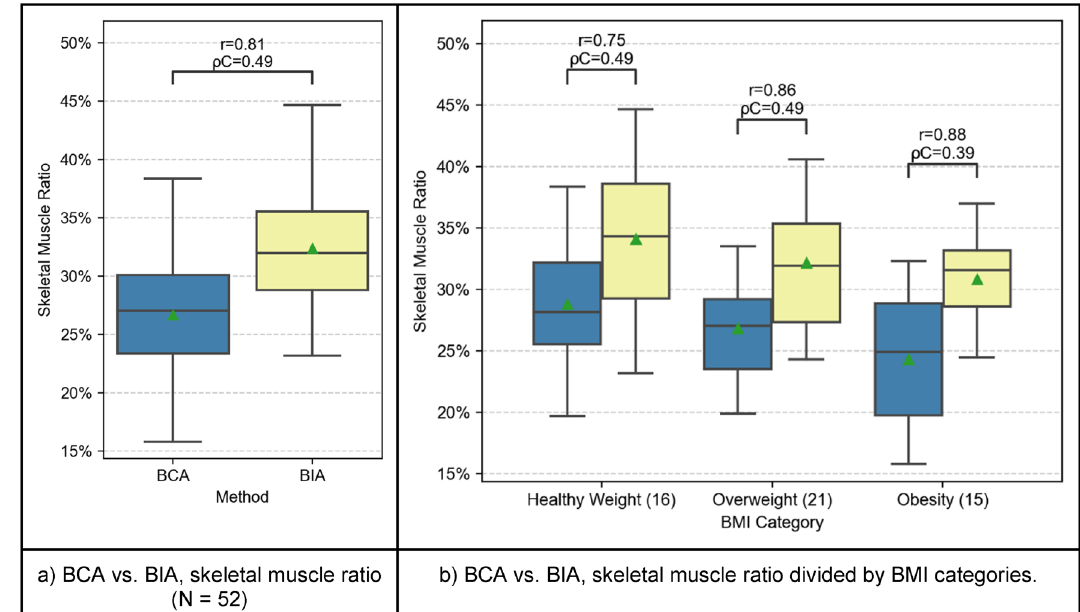
Figure 3. Comparison of SMR between BCA (blue) and BIA (yellow). The boxplots represent the distribution of the patient’s measurements. The mean is indicated with a green triangle and the outliers are indicated with a rhombus. The samples are compared using Pearson’s r correlation coefficient (r) and Lin’s concordance correlation coefficient (ρC).